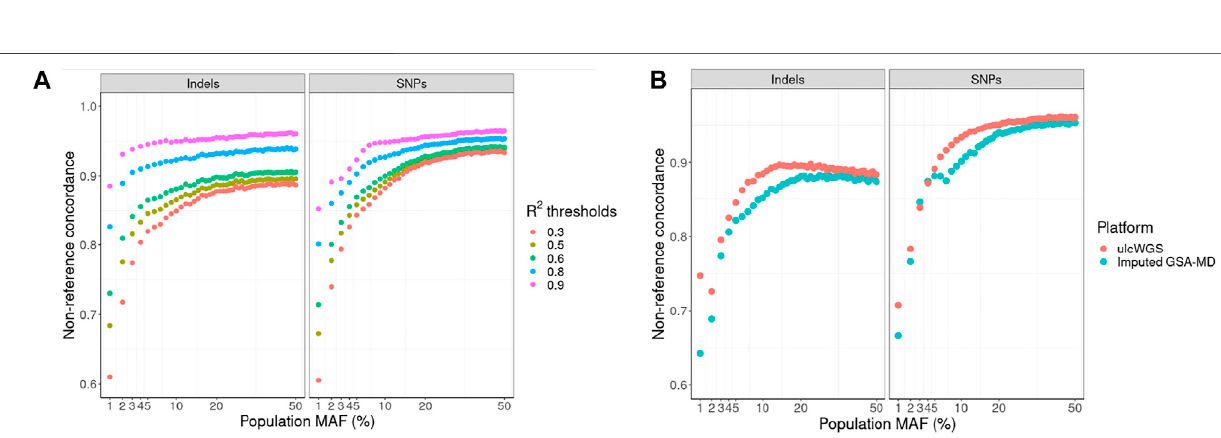
TABLE 2 | Contingency table of sex imputation from ulcWGS and GSA-MD chip/ reported sex.